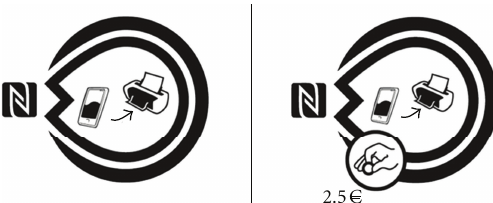
Figure 8: Two examples of a service advertisement for connecting a phone to a photo printer. Left: printing is free. Right: printing costs 2, 5 Euros.